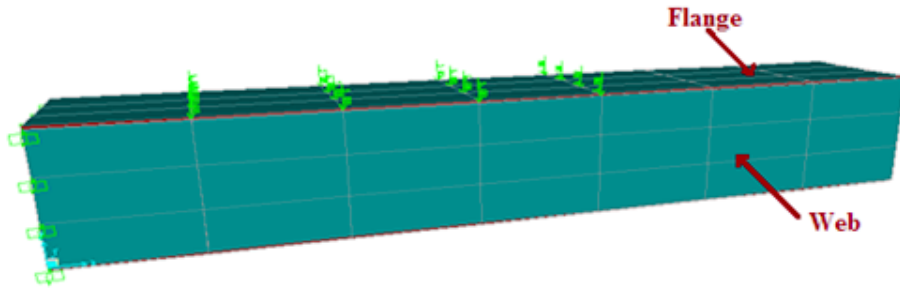
Figure 2. Three dimensional view of the Finite Element model of the cantilever beam 3 m long loaded with UDL until 1.71 m length from the fixed